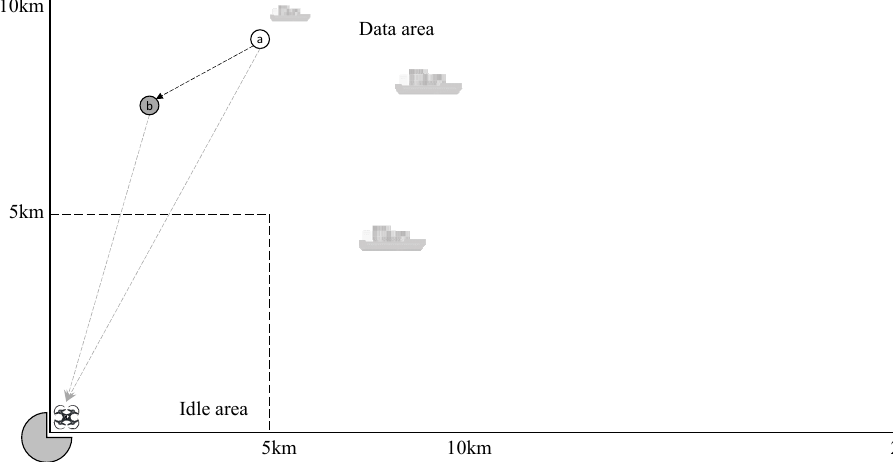
Figure 9. A background diagram for dataset generation.